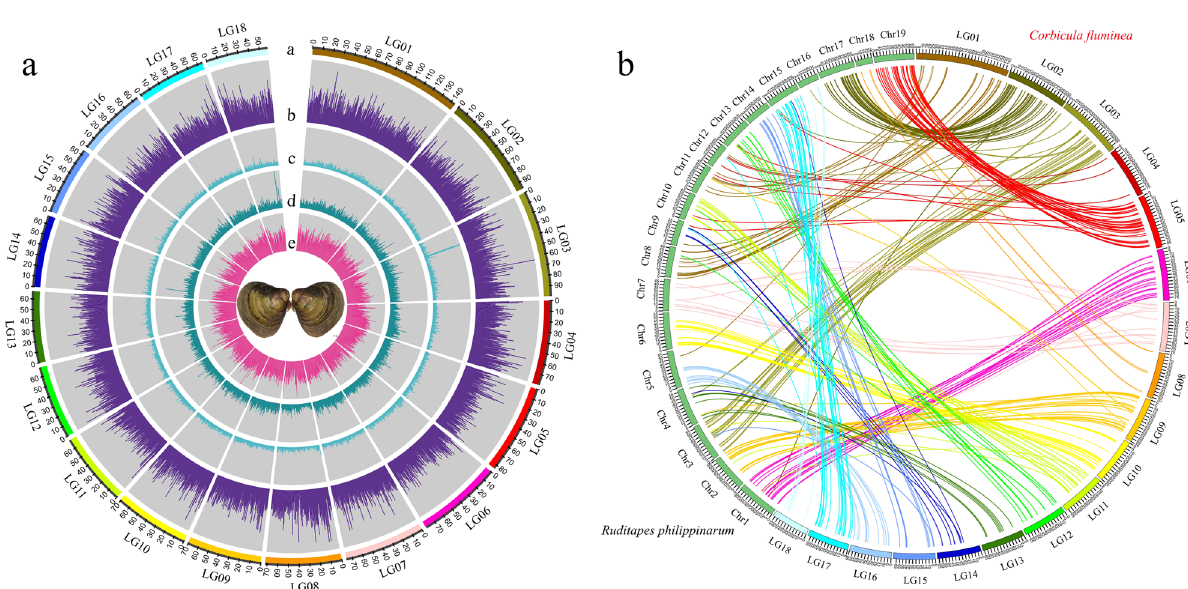
Figure 2. Genome landscape of Corbicula fluminea and the syntenic blocks between C. fluminea and Ruditapes philippinarum . ( a ) In the middle of the circle are C. fluminea . From outer to inner circles: a: marker distribution on 18 chromosomes at the Mb scale; b: LARD distribution on each chromosome; c: PLE distribution on each chromosome; d: gene distribution on each chromosome; e: GC content within a 1-Mb sliding window. ( b ) Syntenic blocks of C. fluminea and R. philippinarum